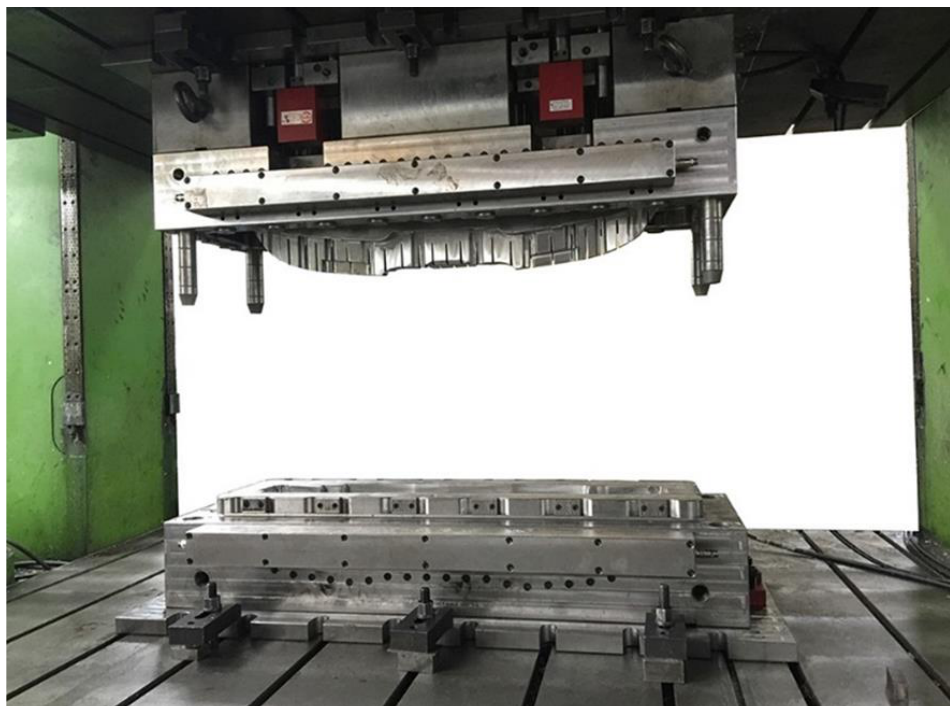
Figure 11. Model of bumper beam with RTM.